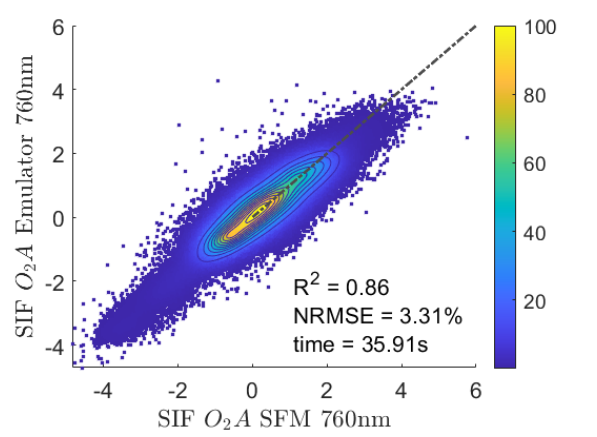
Figure 7. Scatter plot of the SFM SIF map retrieved at 760 nm and the corresponding map emulated with the developed KRR model for the subset of flight line L2. The x-axis represents the SIF values retrieved with the SFM while the y-axis shows the SIF values estimated by the emulator. The dashed line represents the 1:1-line. Units are in (mW m − 2 sr − 1 nm − 1 ).